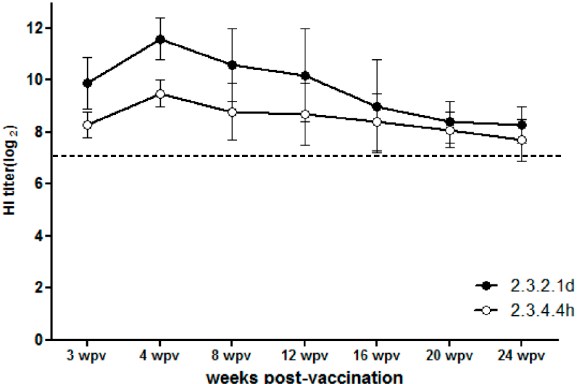
Figure 5. Antibody persistence following vaccination with a full dose of each candidate vaccine. Hemagglutination inhibition (HI) assay titers were measured during the 24 weeks post-vaccination. Titers are expressed as log 2 values. The horizontal dotted line indicates a HI titer of 7 log 2 , which is the standard threshold for prevention of virus shedding.